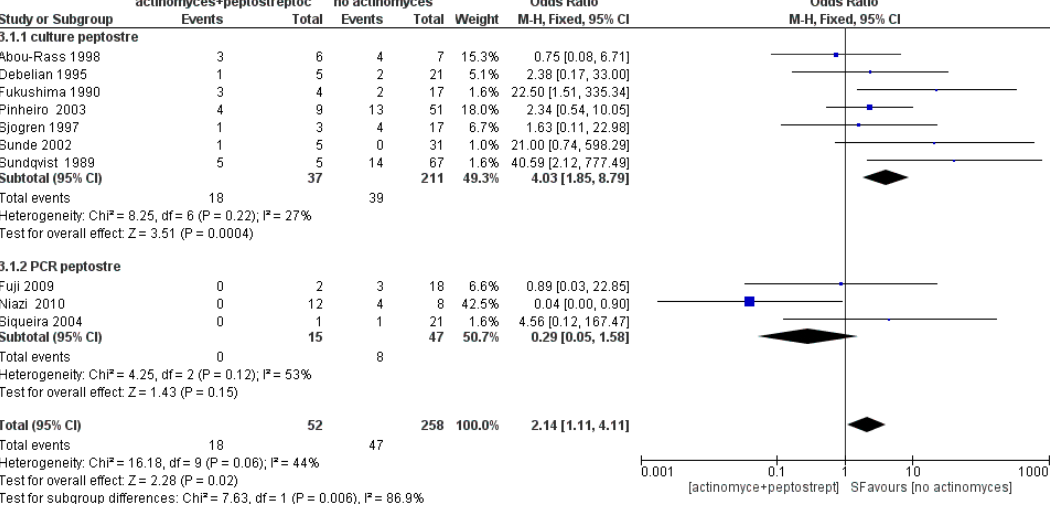
Figure 11. Forest plot of the fixed effects model of the meta-analysis of the sub-group Staphylococci. Sub-group culture (OR = 1.86, 95% CI: [0.49, 7.06]), sub-group PCR (OR = 1.16, 95% CI: [0.22, 6.24]). The meta-analysis of the fifth sub-group Eubacterium showed an absence of heterogeneity, with I 2 equal to 0%, and a fixed effects model was applied. The results shown in Figure 12 show that Eubacterium are more likely to occur in samples with Actinomyces (OR = 2.68, 95% CI: [1.10, 6.51]).